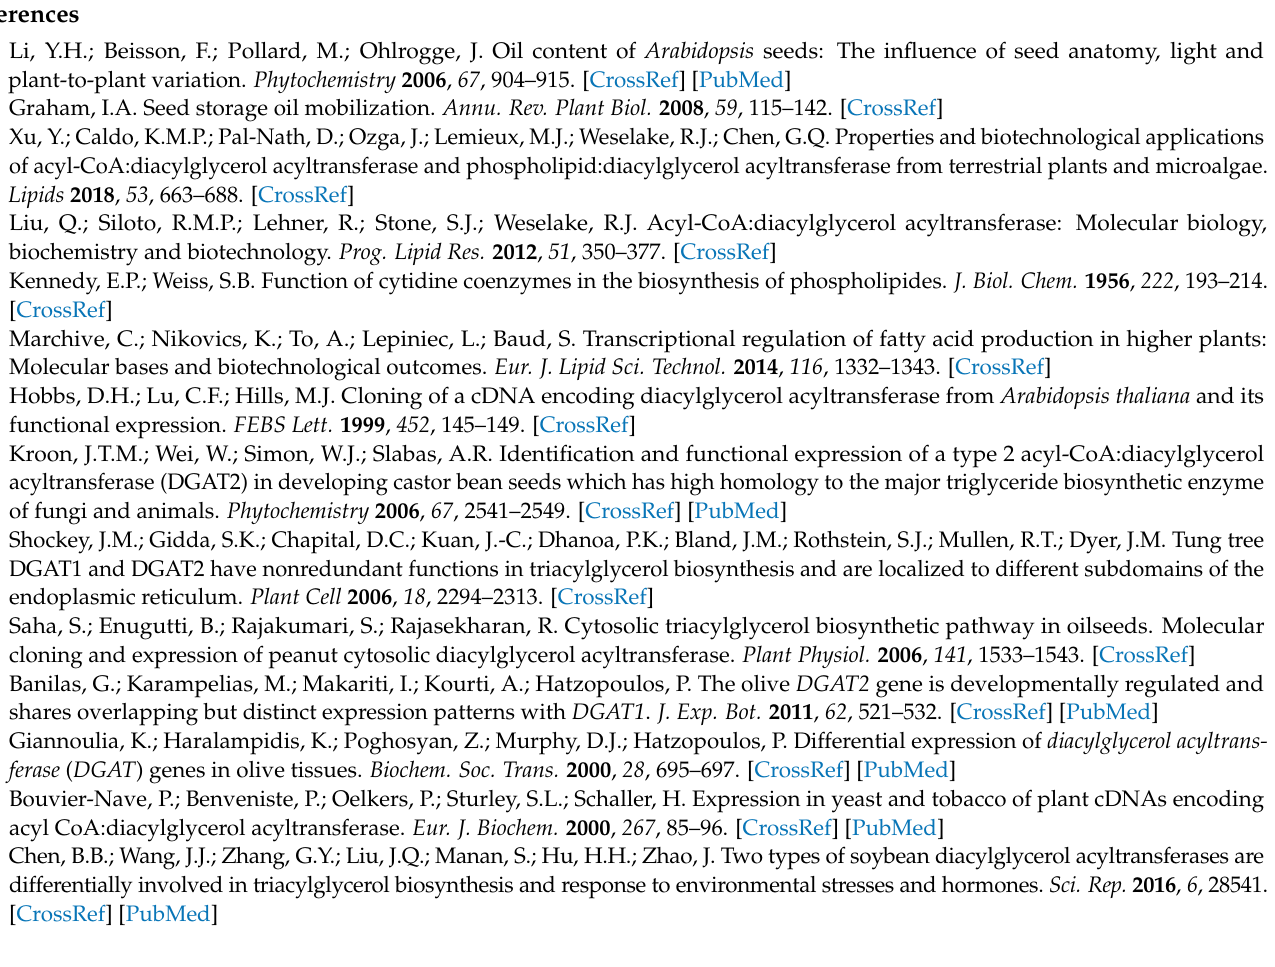
Table S12: miRNAs target B. napus , B. rapa and A. thaliana DGAT genes. References [115–133] are cited in the supplementary